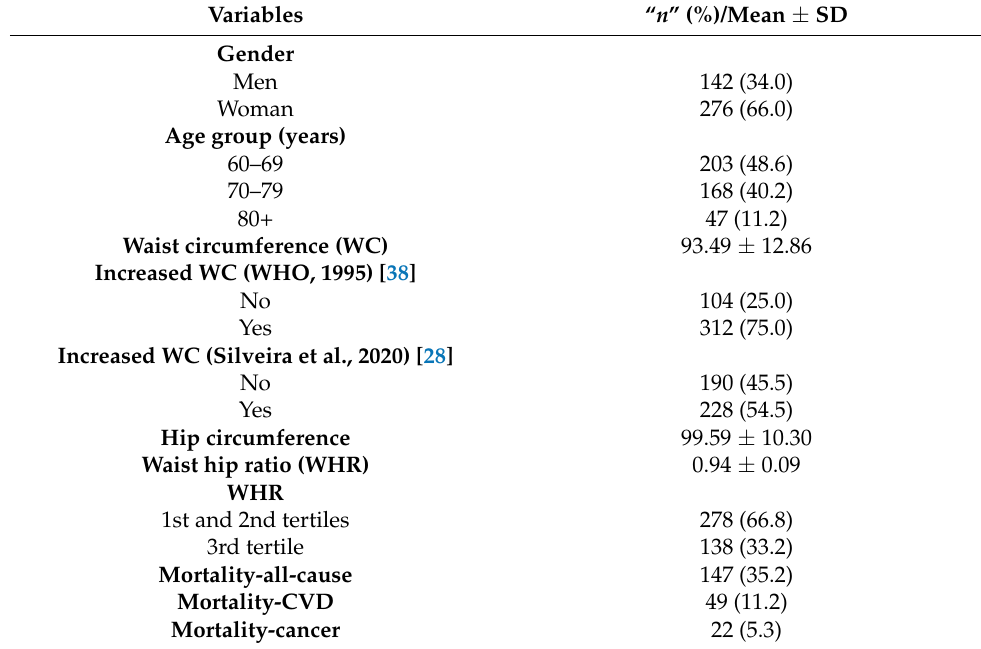
Table 1. Distribution of participants according to sociodemographic characteristics, abdominal obesity indicators and number of deaths from all causes, CVD and cancer.